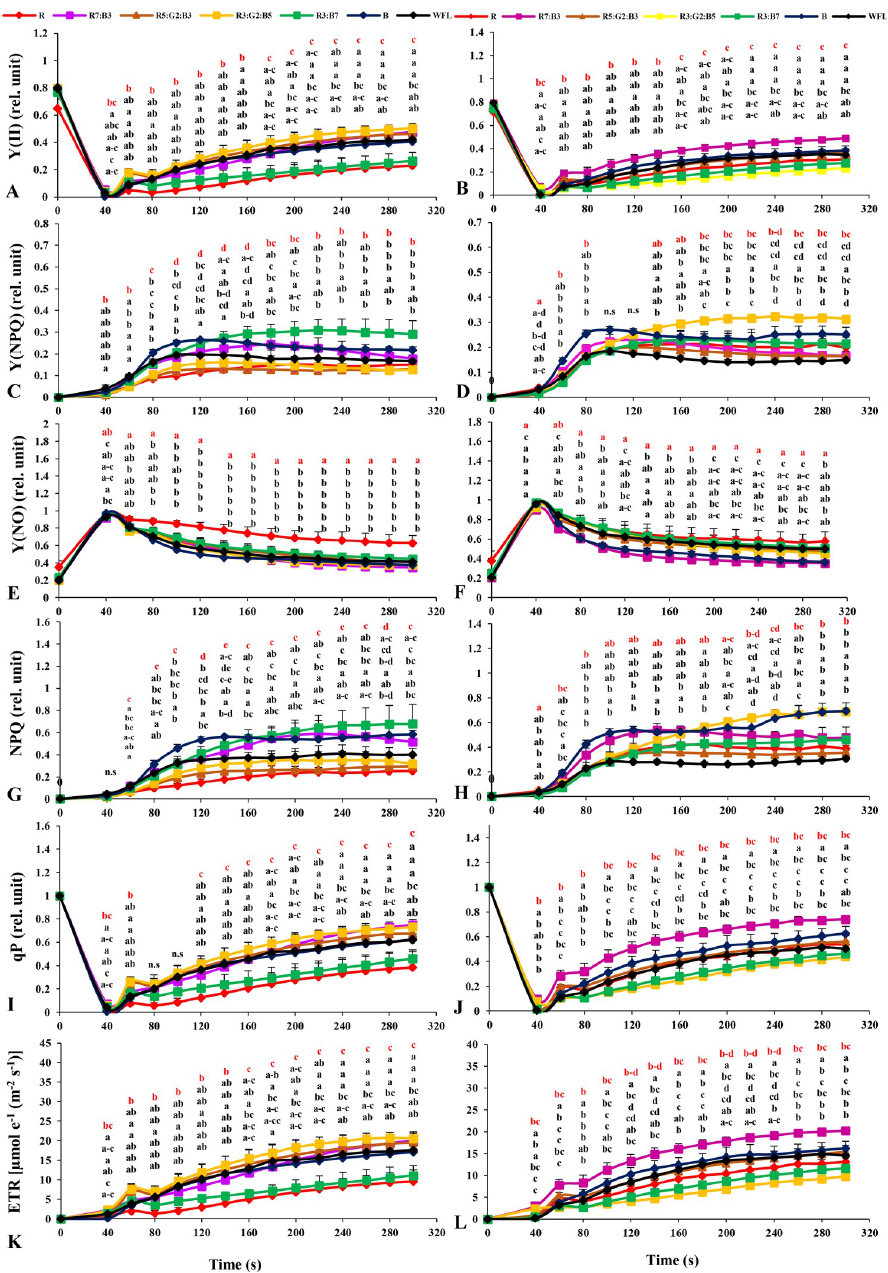
Fig 3. Effects of LED light quality on chlorophyll a fluorescence induction kinetics of the dark-acclimated tomato plants. A and B: effective quantum yield of PSII photochemistry Y(II), C and D: quantum yield of regulatory energy dissipation in PSII Y(NPQ), E and F: quantum yield of non-regulated energy dissipation in PSII Y(NO), G and H: non-photochemical quenching (NPQ), I and J: photochemical quenching coefficient (qP), and K and L: electron transport rate (ETR) in tomato leaves. Gangmu No.1 (A,C,E,G,I,K) and Millennium (B,D,F,H,J,L). Line markers on the curves indicate to the average ± standard error (P � 0.05, n = 4). Sort significance letters from top to bottom according to the treatments (R, R7:B3, R5:G2:B3, R3:G2:B5, R3:B7, B, WFL). Where R = Red light 100%, R7: B3 = Red70%+ Blue30%, R5:G2:B3 = Red50%+Green20%+ Blue30%, R3:G2:B5 = Red30%+Green20%+ Blue50%, R3: B7 = Red70%+ Blue30%, B = Blue light 100%, WFL = White Fluorescent Lamps100%.